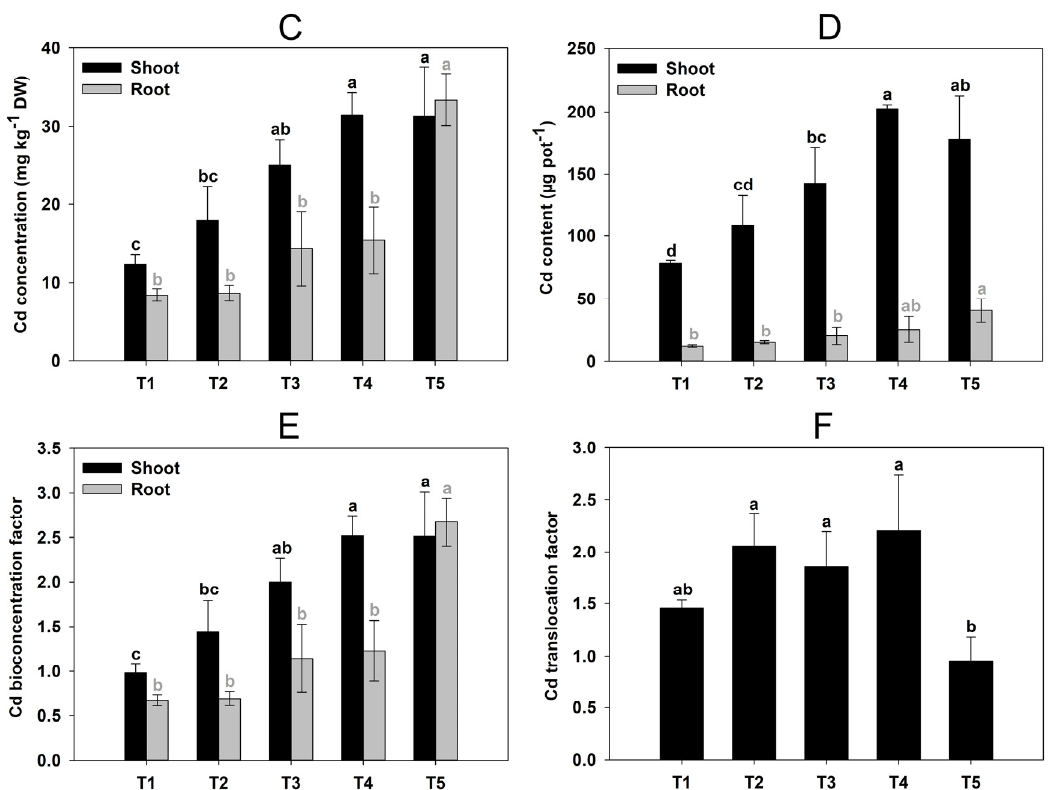
Figure 1. Growth and Cd accumulation characteristics of C. grandiflora in Cd-contaminated soils supplemented with 0 (T1), 1 (T2), 2 (T3), 4 (T4), and 8 (T5) g kg − 1 gamma-aminobutyric acid (GABA). ( A ) Plant morphological features at harvest. ( B ) Plant biomasses (ANOVA for shoot: F = 1.109, P = 0.404, degree of freedom = 4; ANOVA for root: F = 3.140, p = 0.065, degree of freedom = 4). ( C ) Cd concentrations in plants (ANOVA for shoot: F = 9.143, p = 0.002, degree of freedom = 4; ANOVA for root: F = 19.554, p = 0.000, degree of freedom = 4). ( D ) Cd contents accumulated in plants in a single pot (ANOVA for shoot: F = 9.707, p = 0.002, degree of freedom = 4; ANOVA for root: F = 5.131, p = 0.016, degree of freedom = 4). ( E ) Cd bioconcentration factors (ANOVA for shoot: F = 9.049, p = 0.002, degree of freedom = 4; ANOVA for root: F = 19.675, p = 0.000, degree of freedom = 4). ( F ) Cd translocation factors (ANOVA: F = 4.468, p = 0.025, degree of freedom = 4). Data represent means ± standard deviations ( B – F : n = 3); the same-colored bars labelled with different letters (a, b, c, and d) indicate significant differences ( p < 0.05, Duncan’s test, one-way ANOVA) between groups. DW: dry weight.